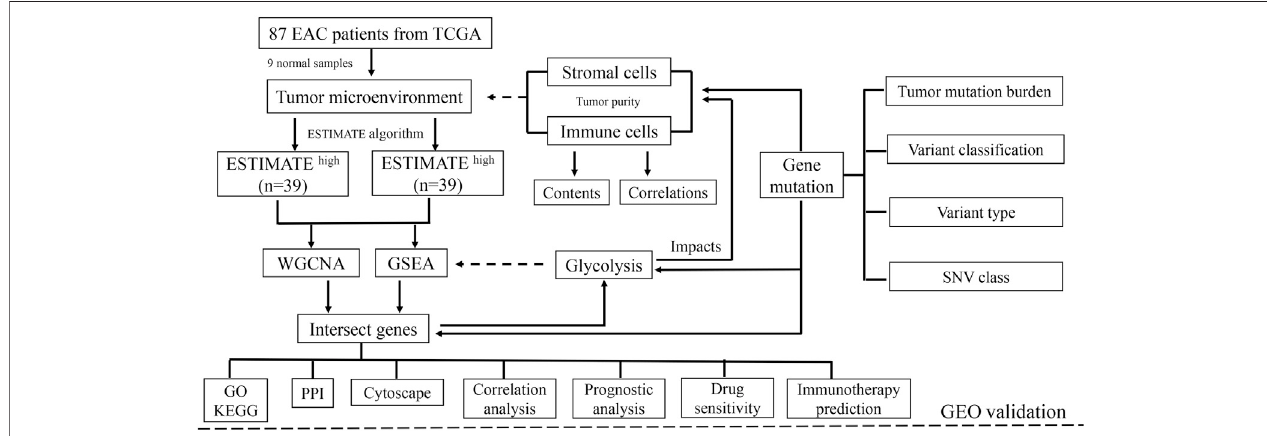
FIGURE 1 | Schematic of the study design. A total of 78 EAC patients were recruited for further study. TME is mainly composed of tumor cells, stromal cells, and immune cells. With higher stromal and immune cells, the tumor purity is low.